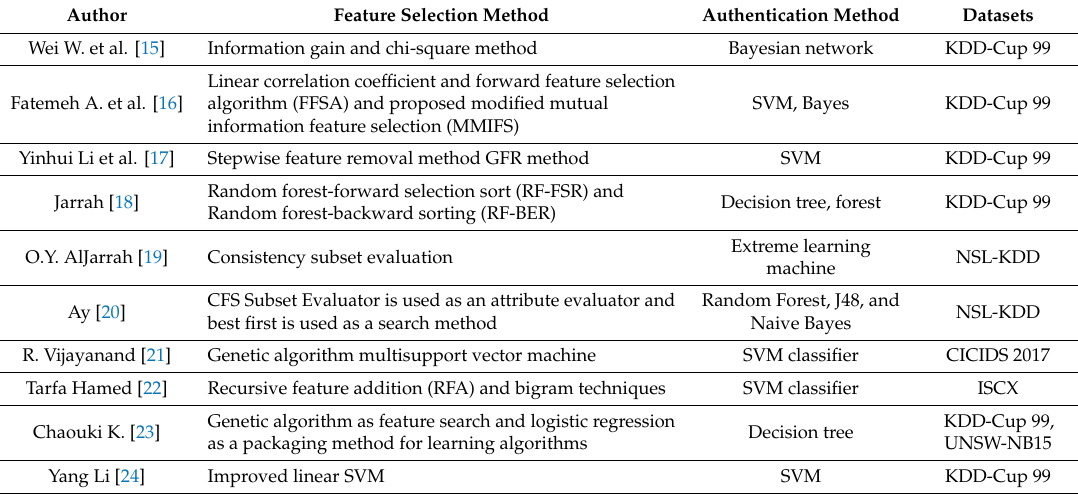
Table 1. Feature selection